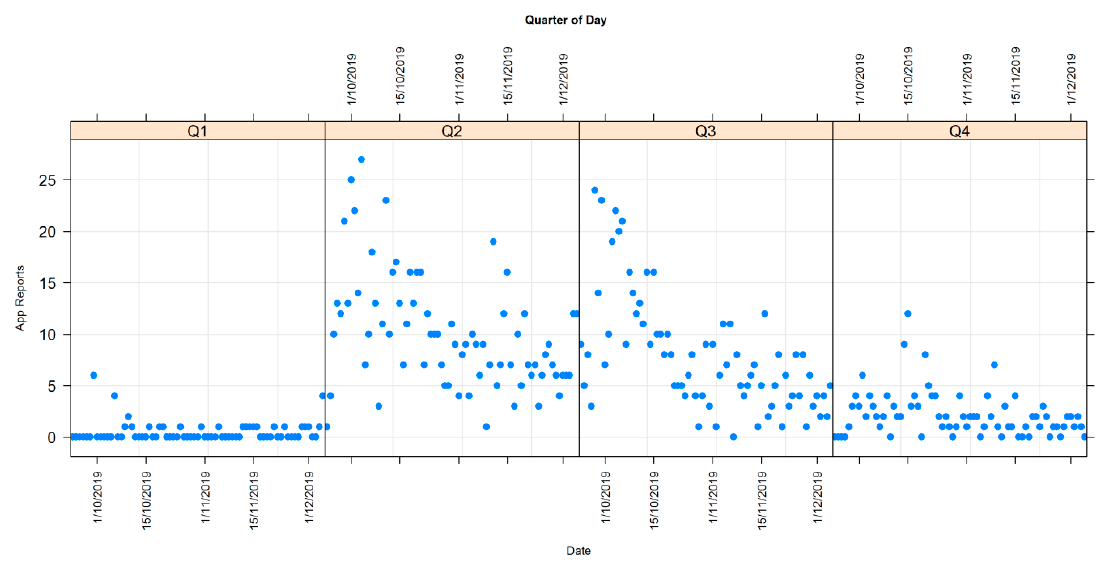
Figure 1. Distribution of roadkill reports by time of day, divided into four quadrants of day.